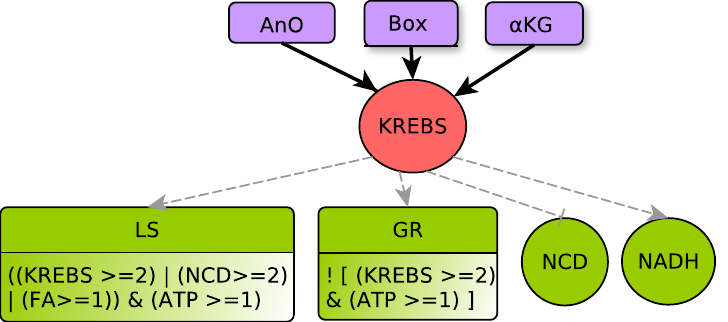
Figure 5. Resources and targets for KREBS